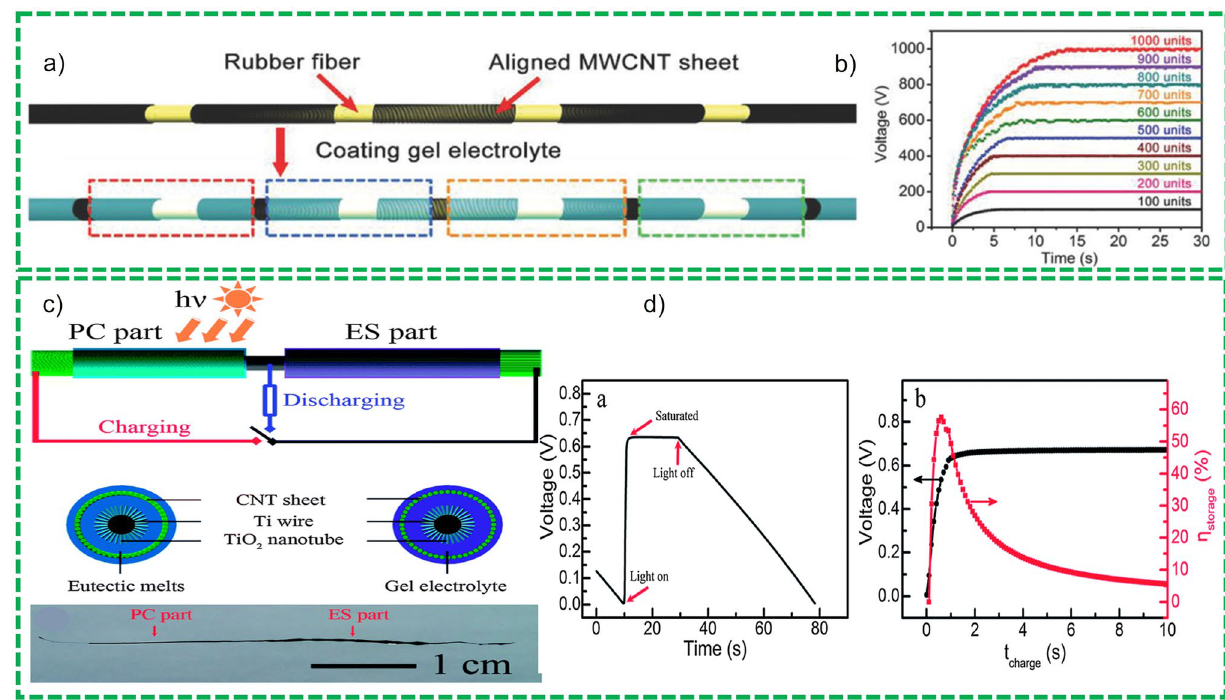
Fig. 21 a Graphical representation of fiber-shaped SCs in series, b relationship between voltage on charging time. Reprinted with permission from Ref. [235]. c Pictorial demonstration of the structure of coaxially integrated photovoltaic device, along with cross-sectional views, d a standard photocharging and discharging of SC, relationship between voltage and storage efficiency on the solar charging time during charging and discharging process. Reprinted with permission from Ref.